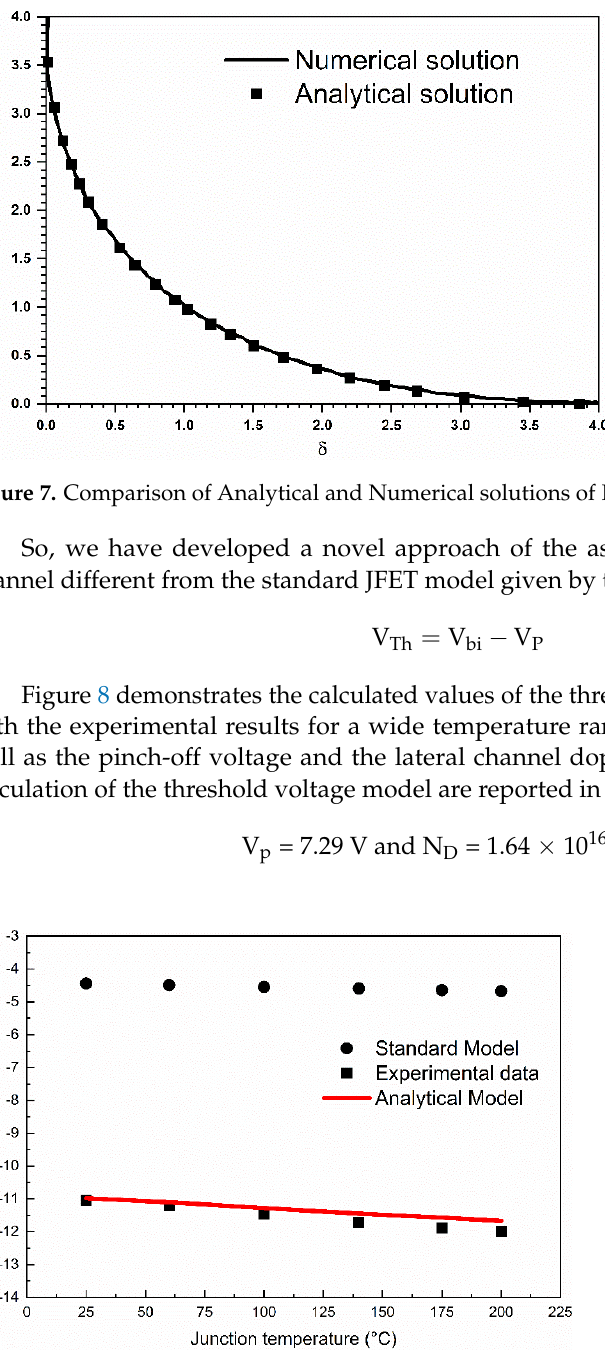
Figure 8. Comparison of the threshold voltage model with Experimental values over a wide range of Temperature.